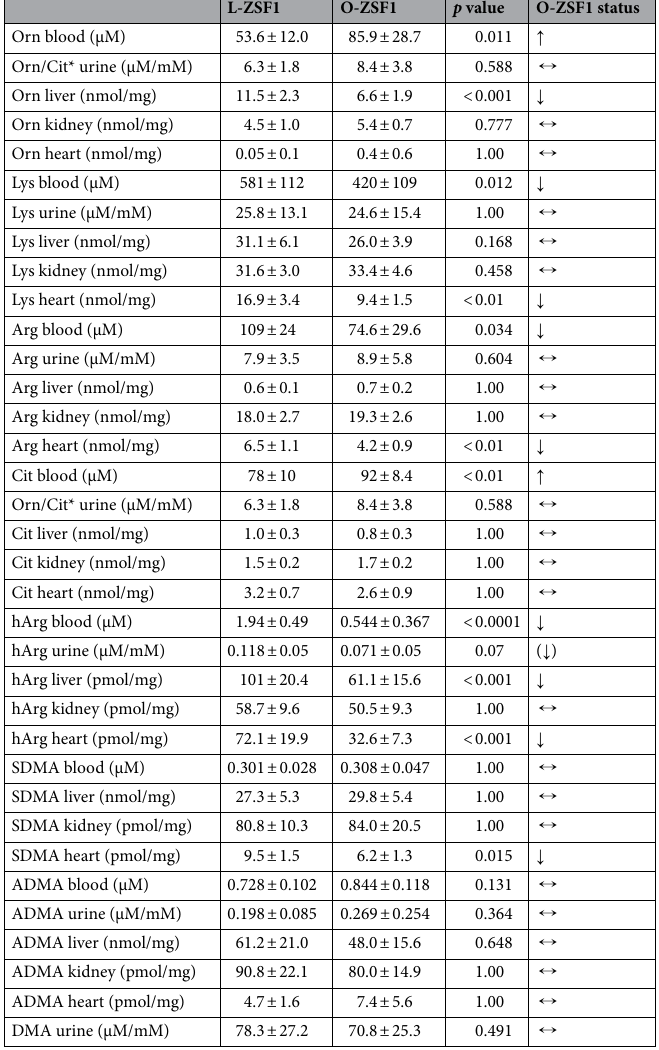
Table 2. Arg and Arg-derived amino acids in O-ZSF1 and L-ZSF1 at the age of 20 weeks. Mean and standard deviation are given. P-value was calculated using Mann–Whitney-U-Test. P -values were corrected for multiple testing. Measurements in urine were normalized to creatinine. In urine Orn and Cit were measured together (*).O-ZSF1 status—Arrows indicate if concentration was higher, lower or even in O-ZSF1 compared to lean. Arrows in brackets indicate a trend p <